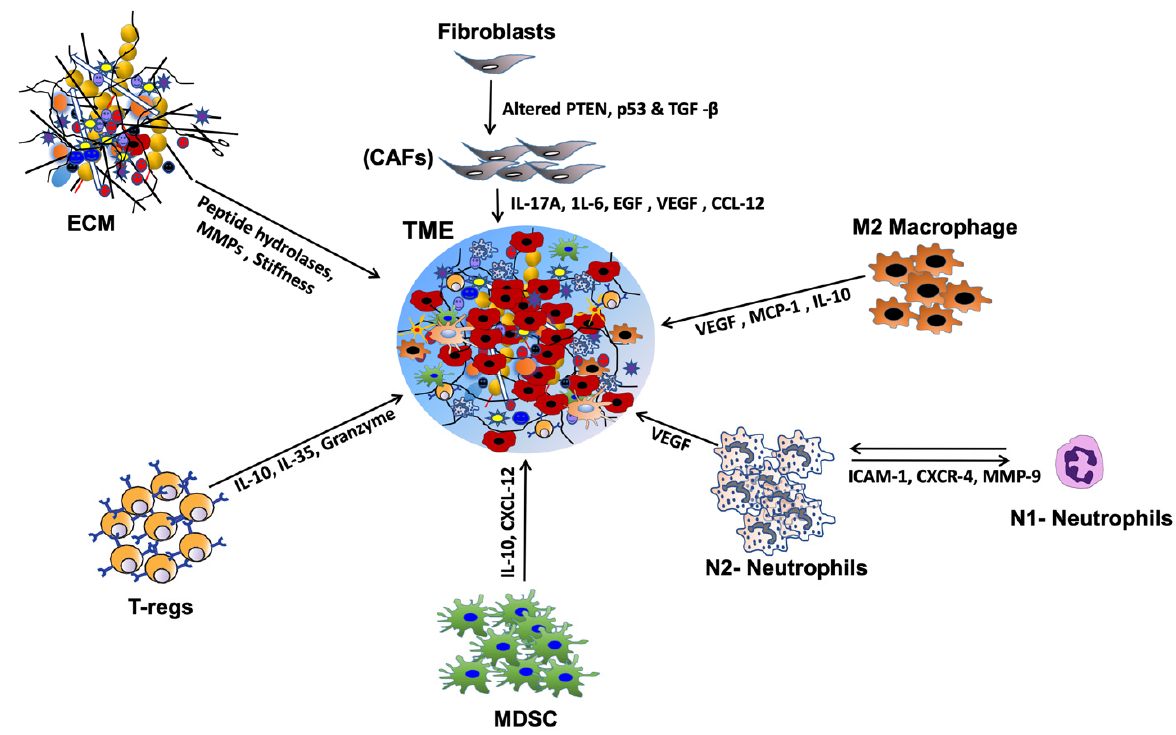
Figure 1. Chemokine and cytokine-mediated crosstalk in head and neck squamous cell carcinoma (HNSCC) tumor micro- environment (TME). Cytokines and chemokines secreted by a variety of stromal cells affect tumor cell growth, proliferation & metastasis in many ways. By inducing immune-suppressive TME, they promote immune evasion and metastasis. Many chemokines and cytokines help degrade extracellular matrix (ECM) proteins, induce angiogenesis, and thereby promote invasion and metastasis.